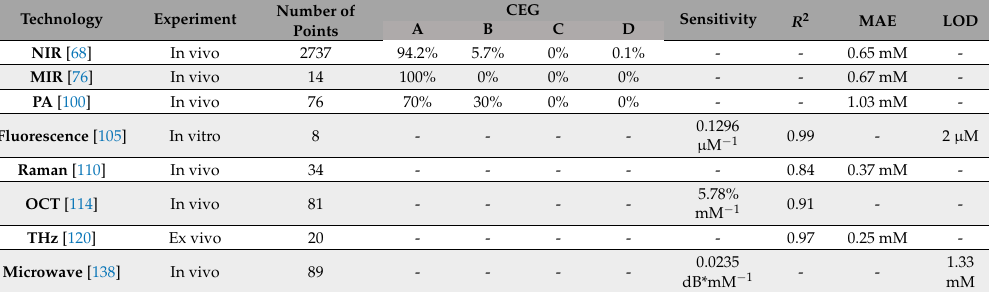
Table 4. Performance comparison of different